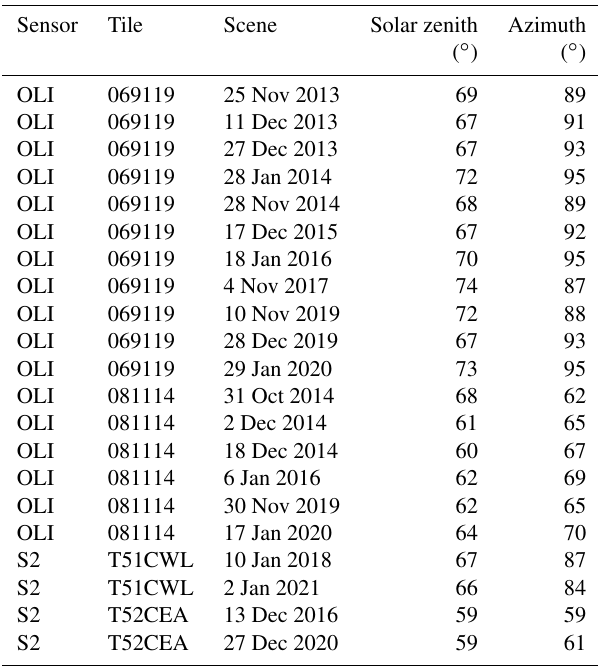
Table A1. Landsat (OLI) and Sentinel-2 (S2) images in the EAIIST (069119 and T51CWL tiles for L8OLI and S2, respectively) and It- ITASE (081114 and T52CEA tiles for L8OLI and S2, respectively) areas used in the study with corresponding solar zenith and azimuth angles from the Landsat/Sentinel metadata.